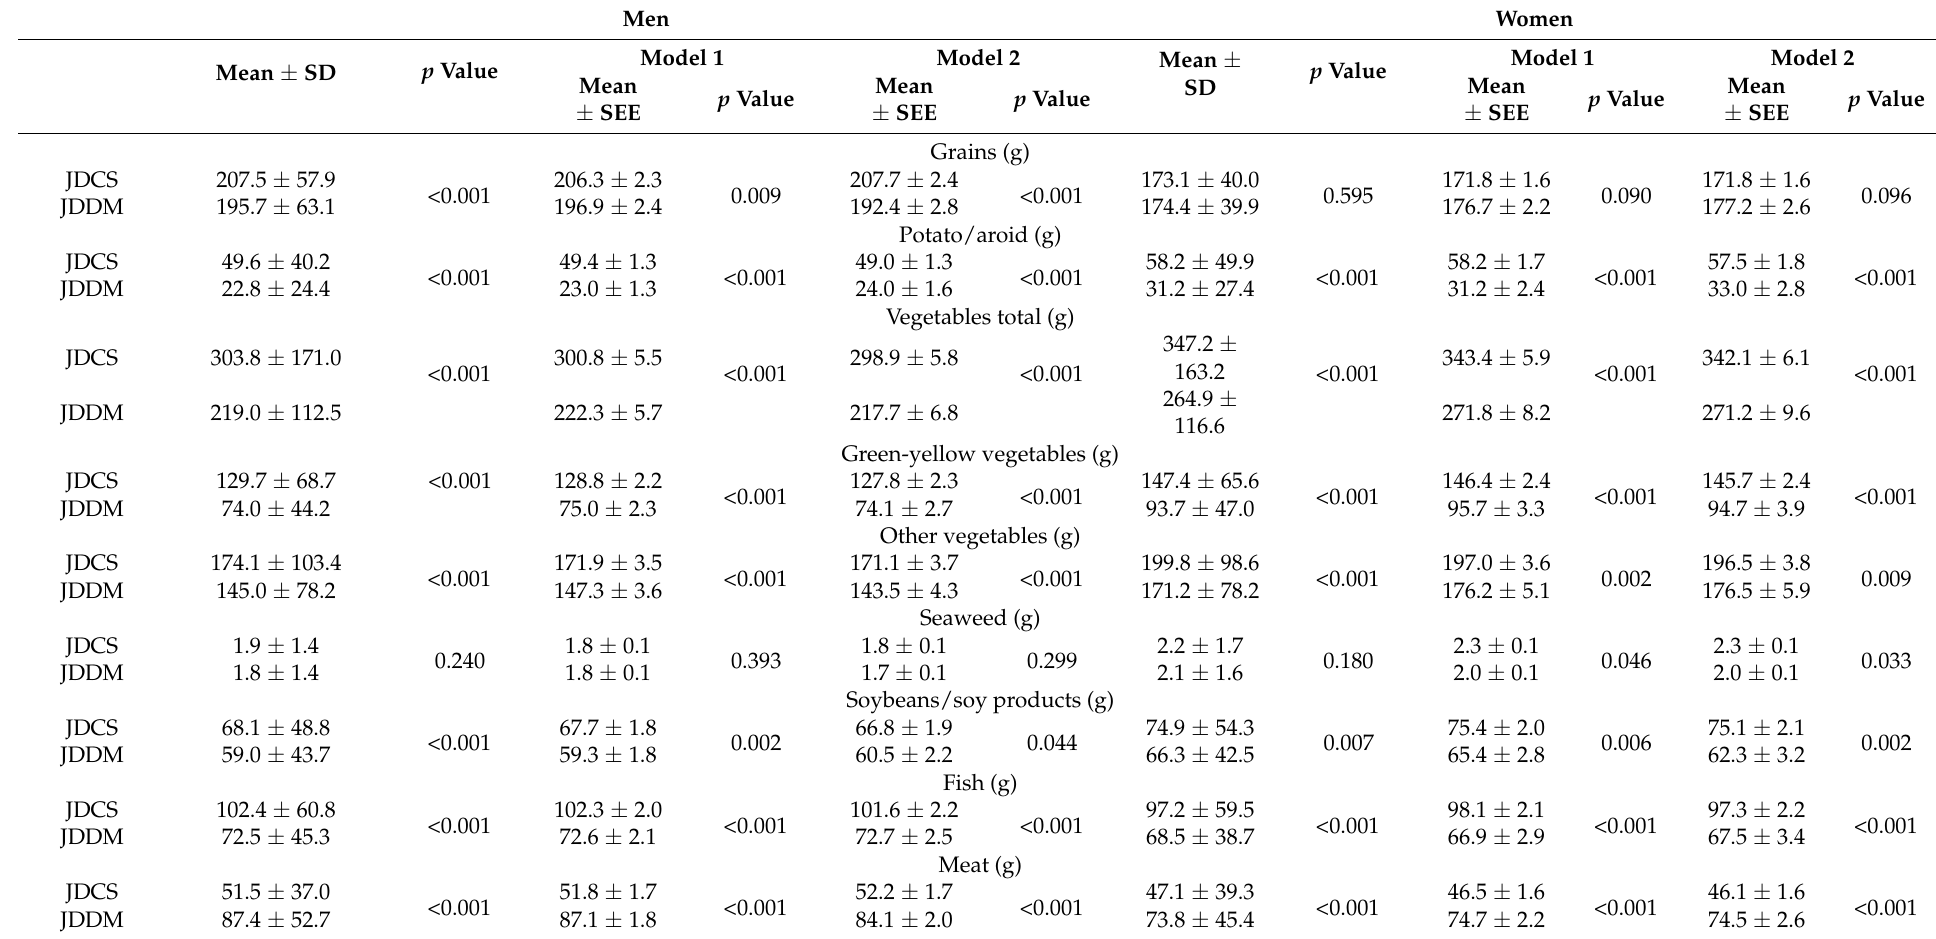
Table 3. Comparison of major food group intake among male and female participants in JDCS (1996) and JDDM